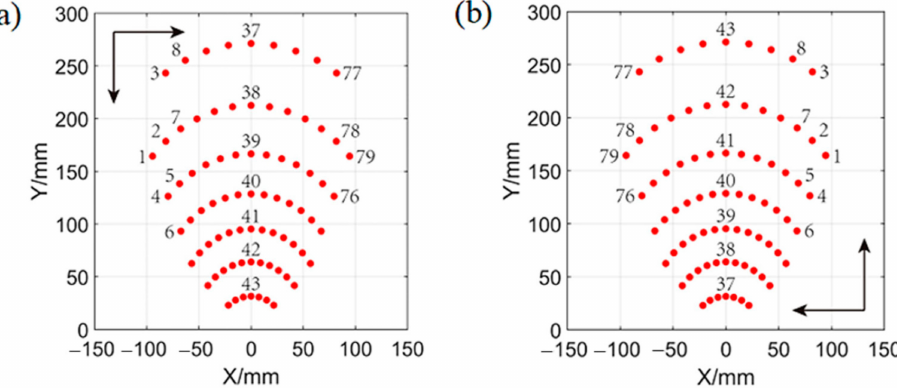
Figure 15. The input order of forward and reverse: ( a ) the forward input order; ( b ) the reverse input